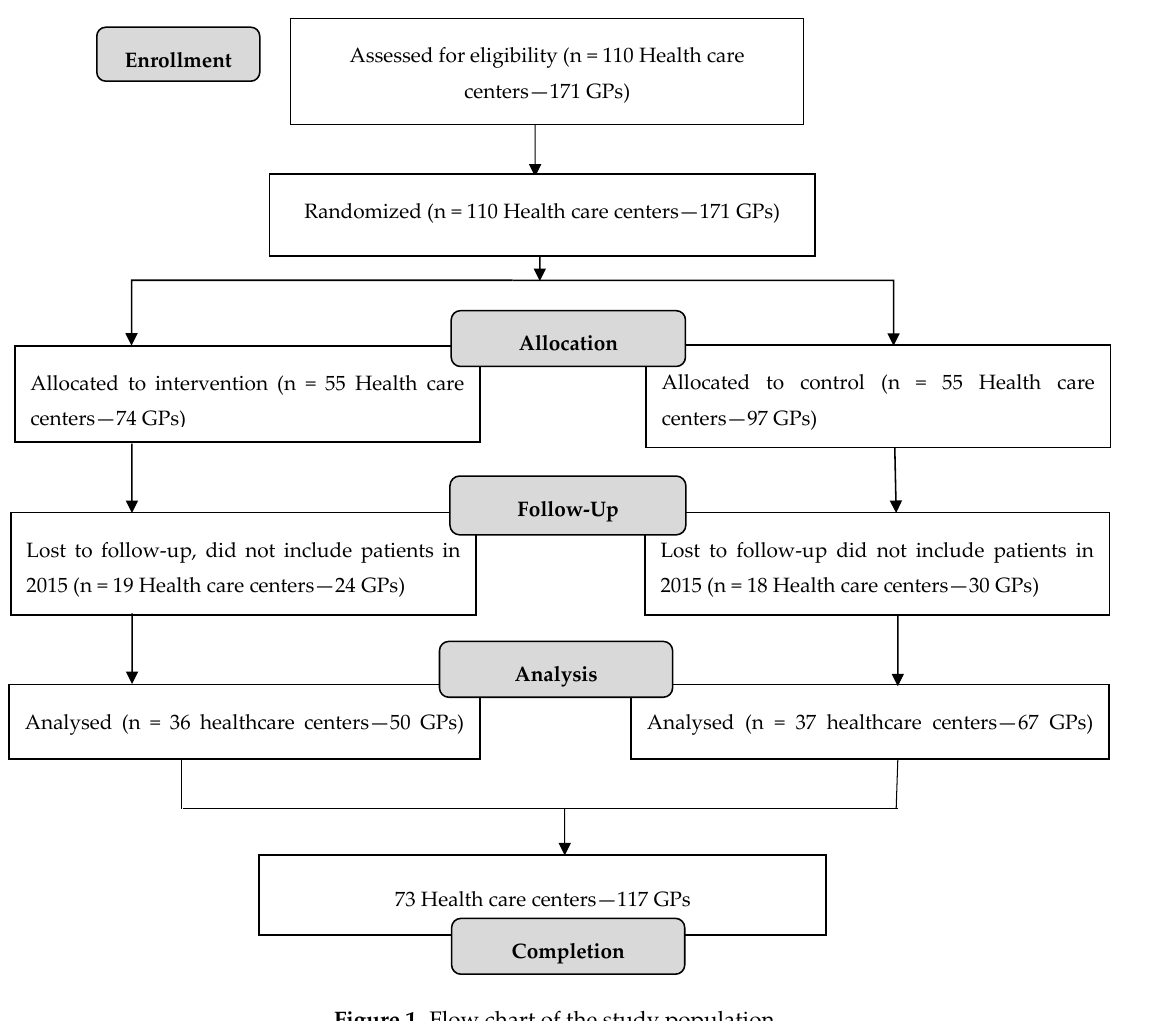
Figure 1. Flow chart of the study population.